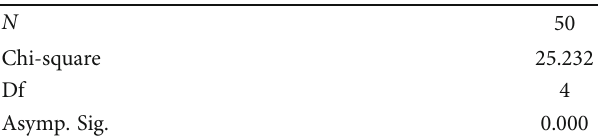
Table 4: Friedman Test statistics of di ff erent CF